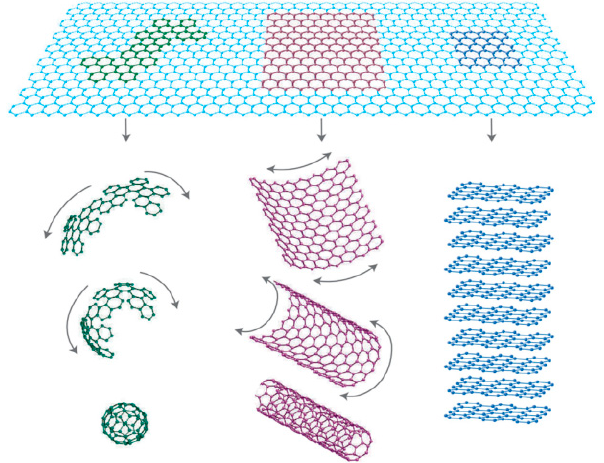
Figure 22. Graphene is a 2D building block of graphitic forms. It wraps to create 0D buckyball, rolls to create 1D nanotube, as well as stacks to create 3D graphite [206].